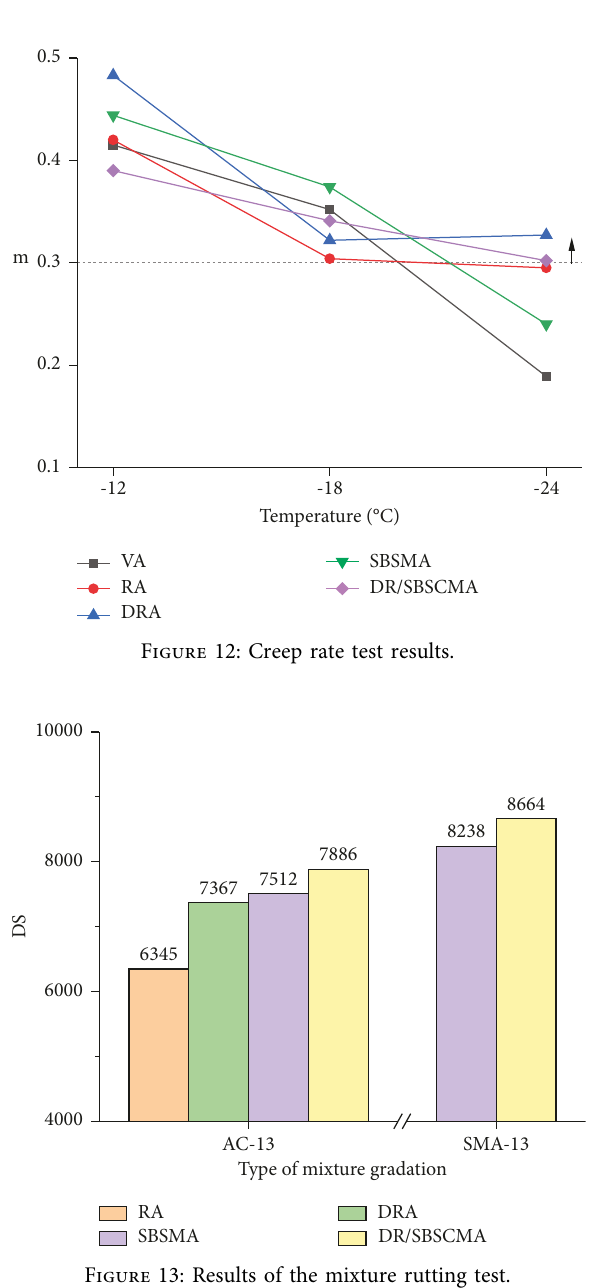
Figure 13: Results of the mixture rutting test.